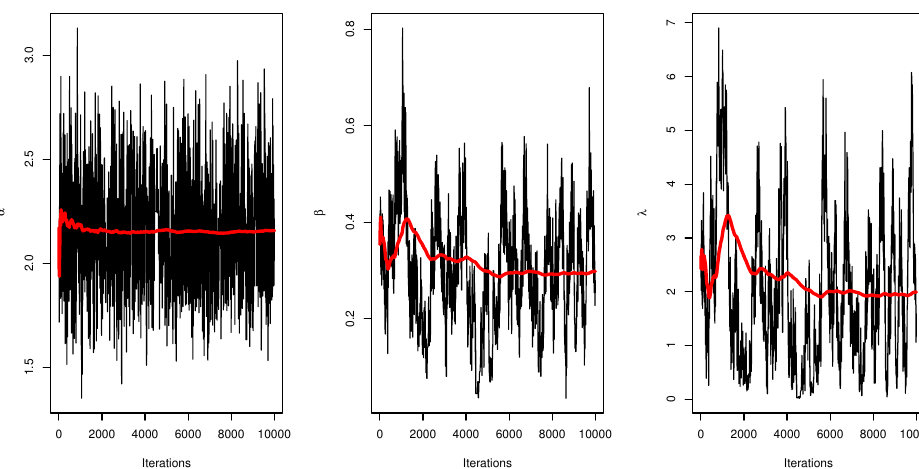
Figure 21. Trace plot of MCMC results for parameters of UEPD for the failure of 20 components